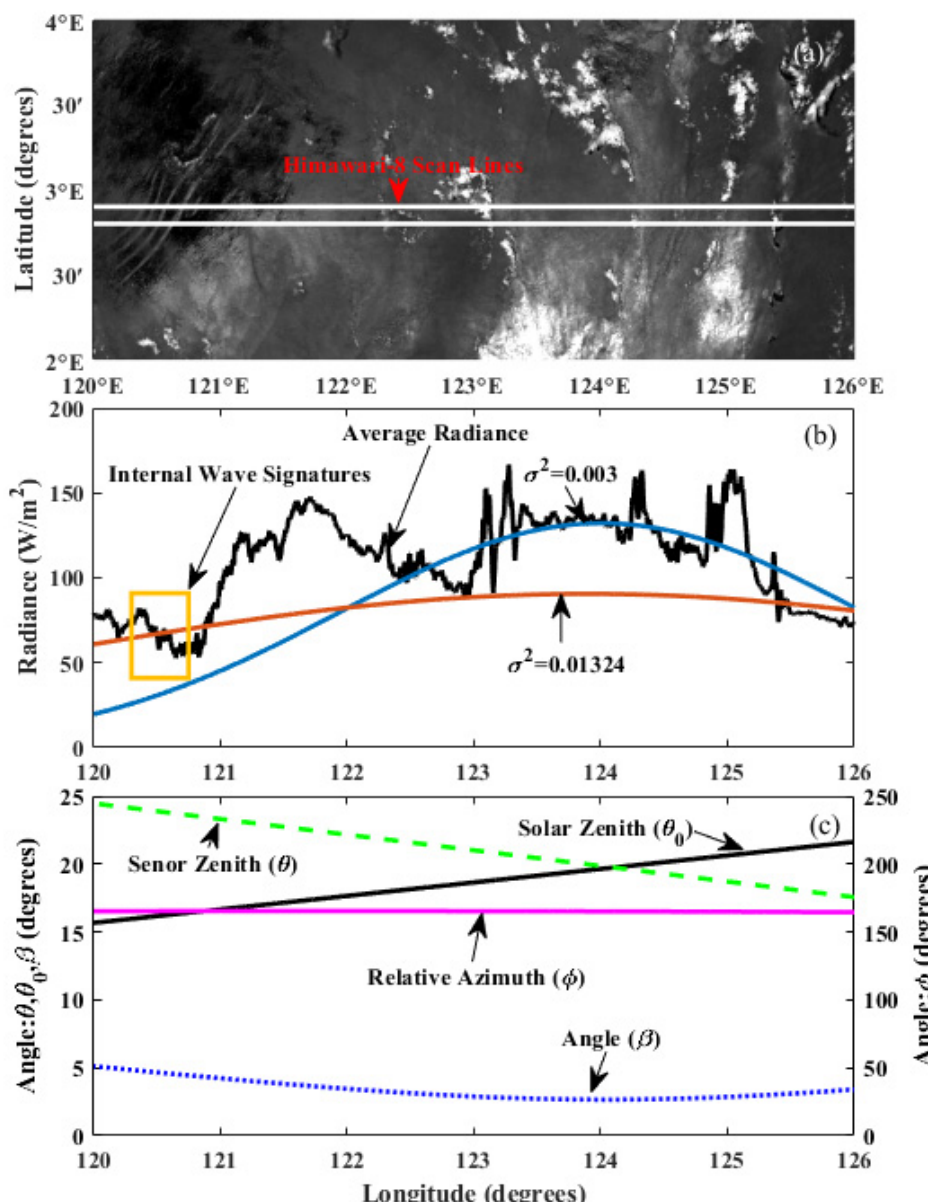
Figure 7. Analysis of the image acquired on 21 September 2020 at 04:50 UTC. ( a ) shows part of the Himawari-8 image of the Celebes Sea acquired on 21 September 2020 at 04:50 UTC, and the white solid line indicates the scan line of the AHI sensor onboard the Himawari-8 satellite; ( b ) shows curves of the normalized solar radiance calculated with roughness variance ( σ 2 ) values of 0.003 and 0.01324 and the average measured radiance along the scan line, and the yellow box marks the position of the internal solitary waves. The blue and orange curves indicate the radiance information of the sea surface background and internal solitary waves, respectively; ( c ) shows the changes in the solar zenith angle ( θ 0 ), sensor zenith angle ( θ ), relative azimuth angle ( φ ), and surface facet tilt ( β ) along the AHI sensor scan line. The solid black line indicates the change in the solar zenith angle ( θ 0 ) along the scan line. The green dashed line indicates the change in the sensor zenith angle ( θ ) along the scan line. The purple solid line indicates the relative azimuth angle ( φ ) along the scan line. The blue dotted line indicates the change in the surface facet tilt ( β ) along the scan line.